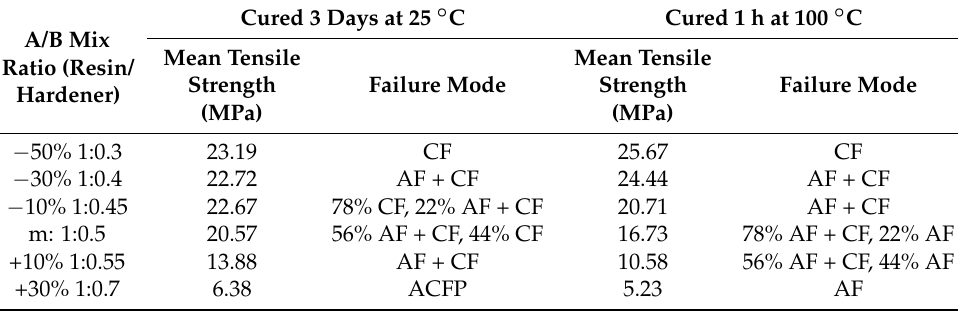
Table 4. Failure mode change after heat curing samples tested at 70 ◦